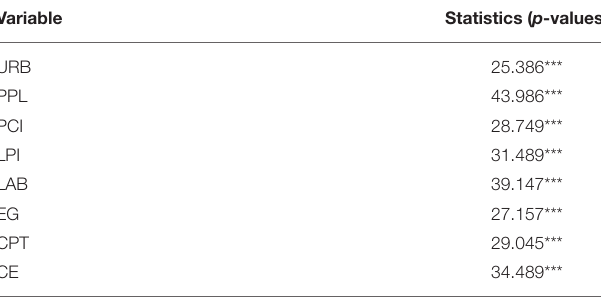
TABLE 2 | Results of cross-sectional dependence analysis.